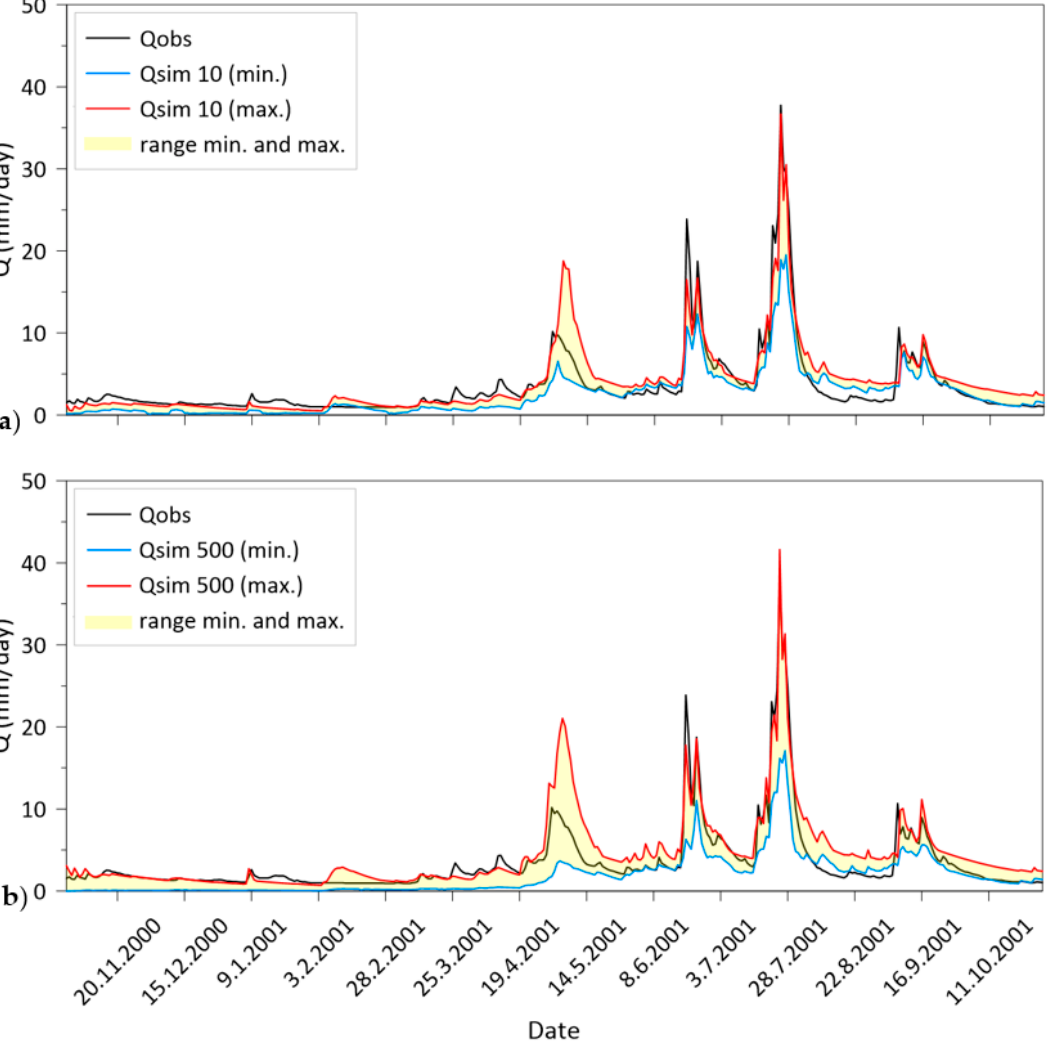
Figure 8. Comparison of measured and simulated runoff after 10 ( a ) and 500 simulations ( b ). Runoff is simulated in a colder/wetter validation period (2001–2006) with model parameters obtained in a warmer/drier calibration period (1989–1994). The yellow colour indicates the range between the minimum (blue line) and maximum (red line) simulated runoff obtained by 10 and 500 repetitions.